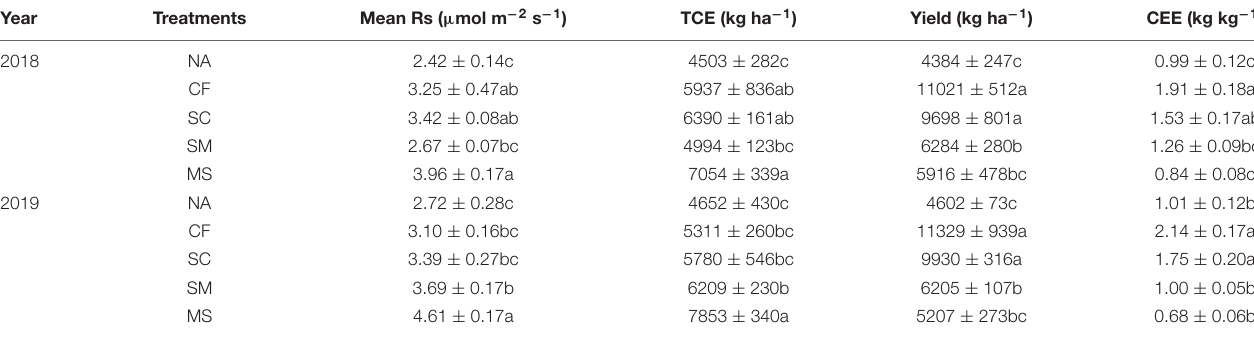
TABLE 2 | Mean soil respiration (Rs), total carbon emission (TCE), crop yield, and carbon emission efficiency (CEE) in 2018 and 2019 under five treatments. Year